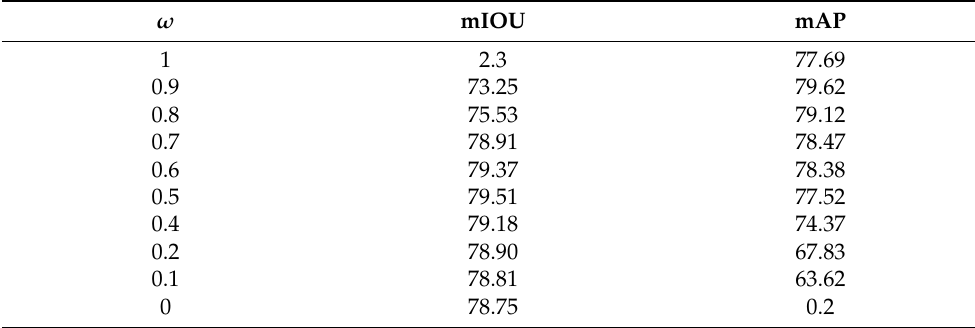
Table 2. Metrics of The Proposed Network with Different